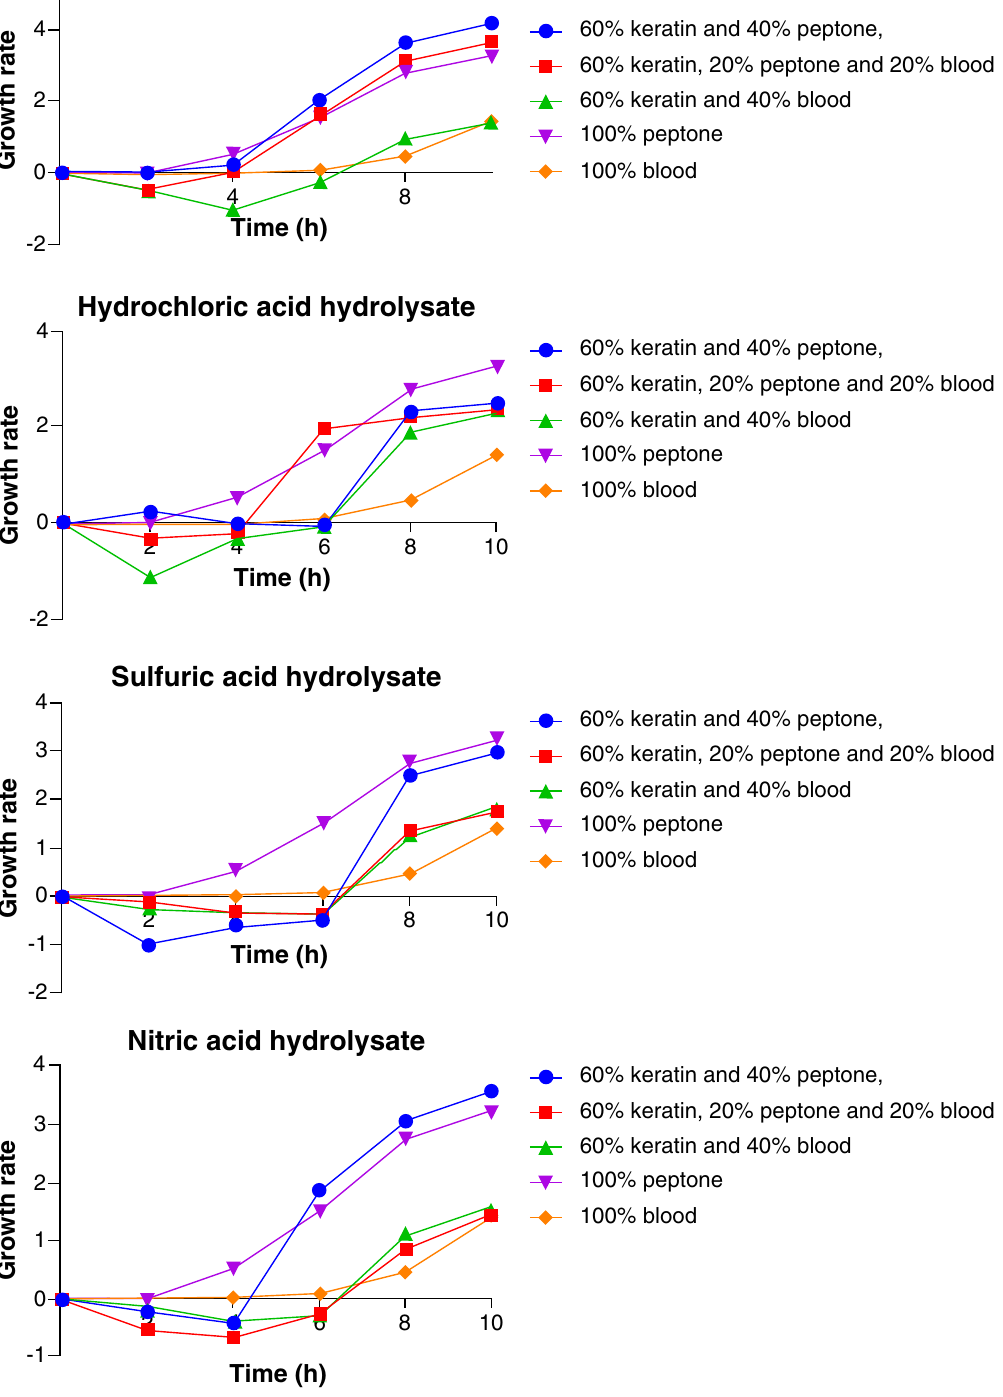
SO and HNO 2 4 3